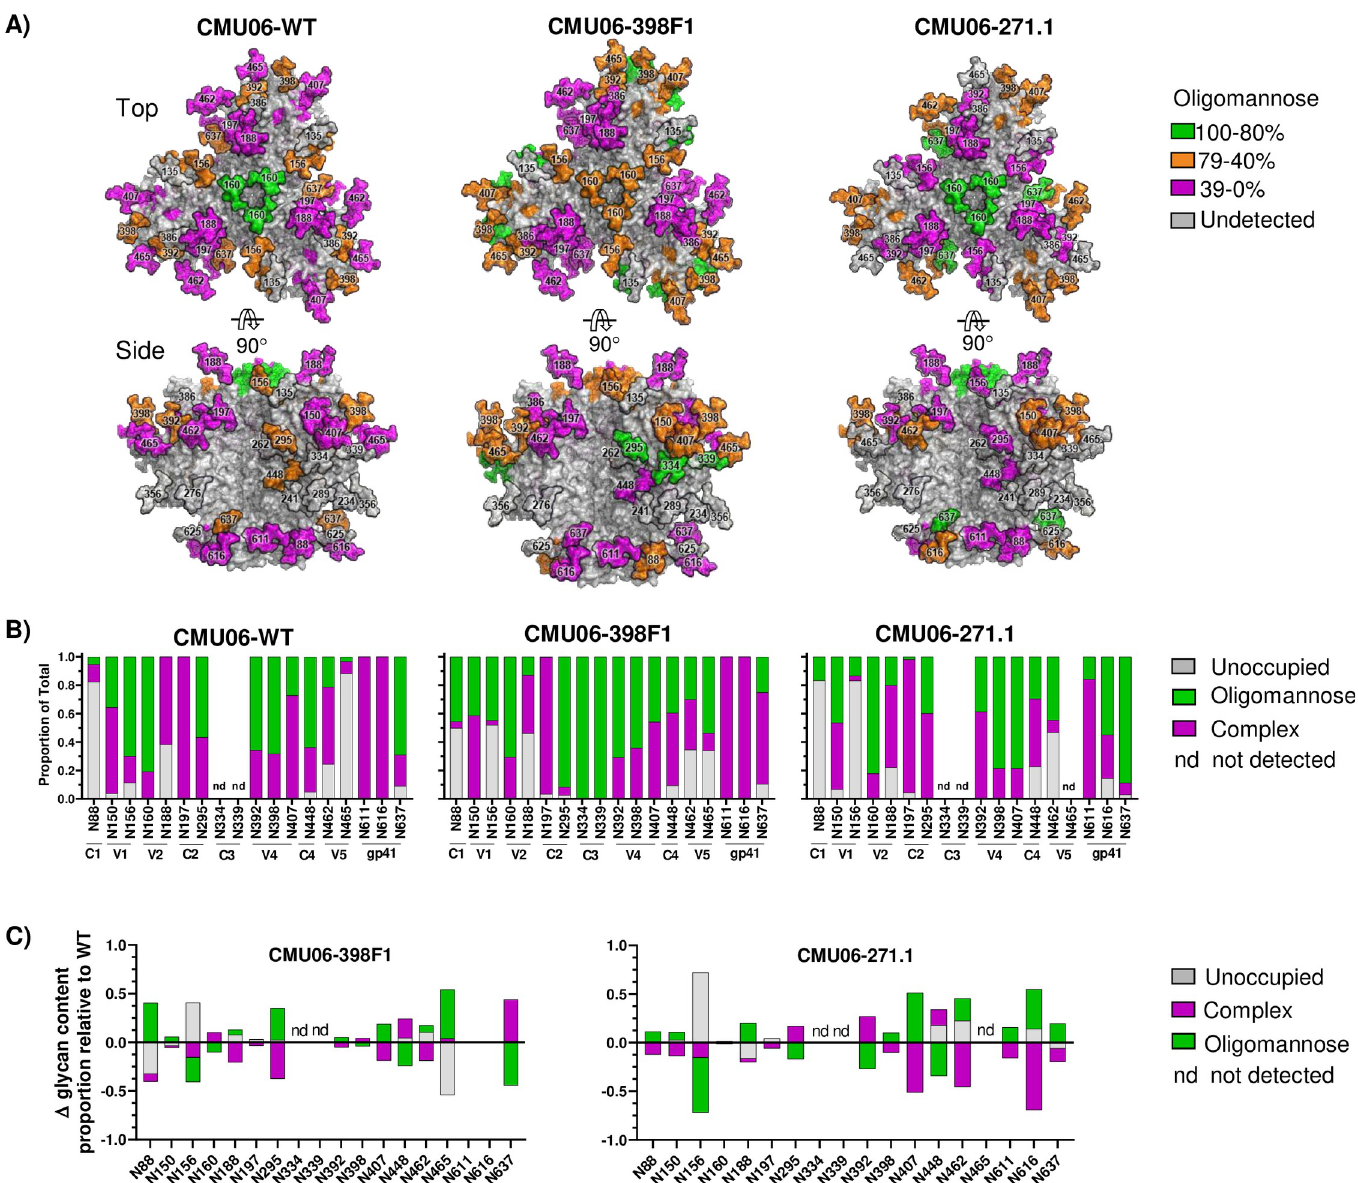
Fig 3. Effect of SP swap on CMU06 Env glycosylation. (A) Env trimer models (generated using a SOSIP.664 trimer PDB 5FYJ) showing the predominating glycoforms at each of the CMU06 glycosites for CMU06-WT, CMU06-398F1, and CMU06-271.1. Type of glycans added was based on LC-MS/MS data of virion-associated Envs from 293T cells (Fig 3B). (B) Relative amounts of unoccupied, oligomannose, and complex glycans at glycosites on SP-swapped vs WT CMU06 as determined by LC-MS/MS. nd: glycosites not detected in 1 or 2 Envs. Glycosites undetected in all 3 Envs are not shown. (C) Changes in glycan content at each glycosite for CMU06-398F1 and CMU06-271.1 vs CMU06-WT calculated from Fig 3B